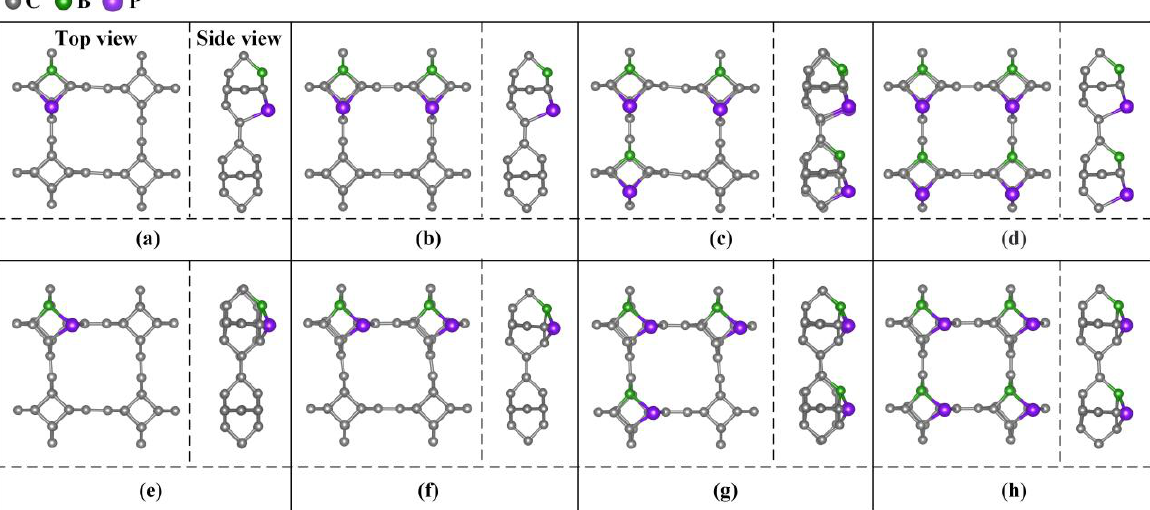
Figure 3. B and P co-doped 2 × 2 × 1 TTG supercell with doping at the para (TTG/BP-para) and ortho (TTG/BP-ortho) positions with different doping concentrations. ( a ) TTG/BP-para-4.2%; ( b ) TTG/BP-para-8.3%; ( c ) TTG/BP-para-12.5%; ( d ) TTG/BP-para-16.7%; ( e ) TTG/BP-ortho-4.2%; ( f ) TTG/BP-ortho-8.3%; ( g ) TTG/BP-ortho-12.5%; ( h ) TTG/BP-ortho-16.7%. Table 1. Formation energy ( E f ) and band gap values of co-doped TTG systems.